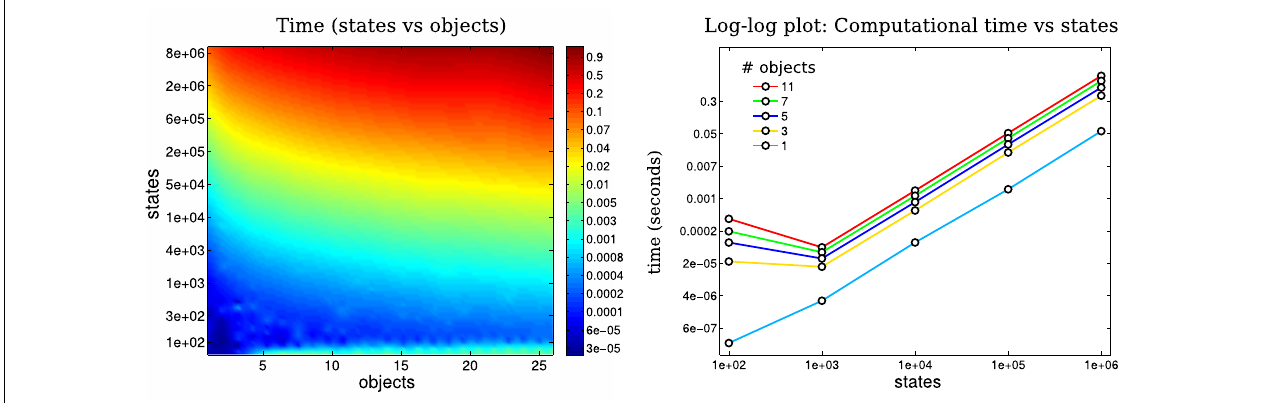
FIGURE 11 | Time complexity: Left: mean time taken for a loop update (motion and measurement) as a function of the number of states in a marginal and the number of objects present. Right: Log–log plot of time taken for a loop update with respect to the number of states in the marginal. The color coded lines are associated with the number of objects present. As the number of states increases exponentially the computational cost matches it.